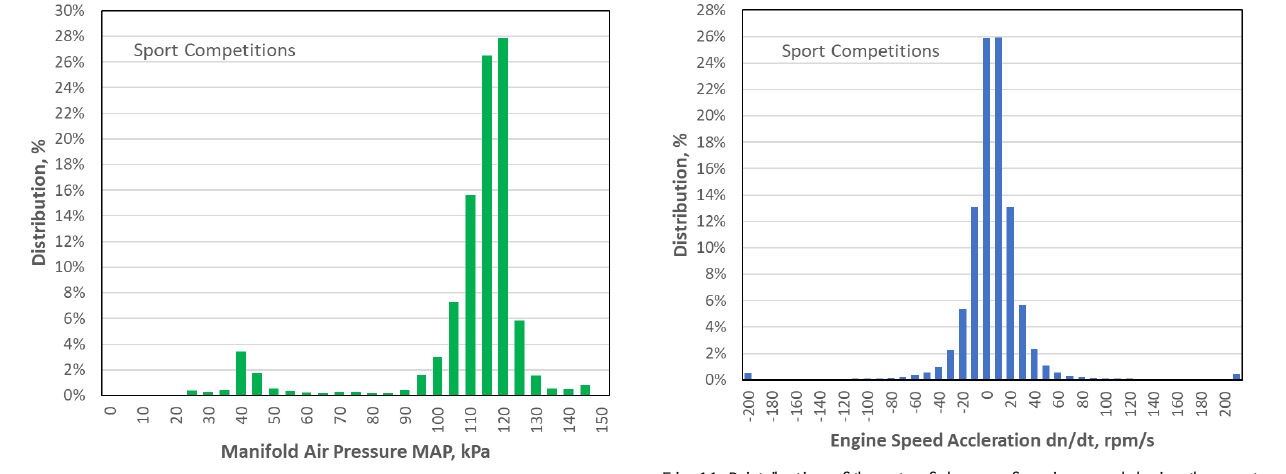
Fig. 11. Distribution of the rate of change of engine speed during the sport competition